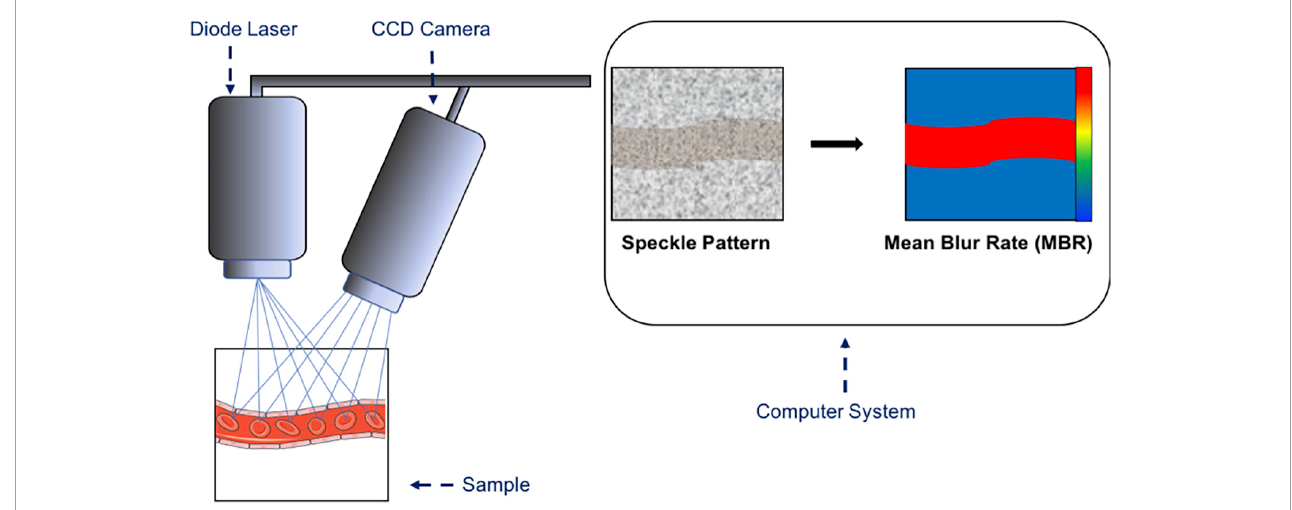
FIGURE4 Sketch of the principle of laser speckle flowgraphy. A microscope equipped with a diode laser is coupled to a charge-coupled device (CCD) camera. The laser light is reflected by the irregular surface of the fundus and is translated into a speckle pattern of the scattered light. The mean blur rate (MBR) is calculated from the speckle pattern and is a relative index of blood flow velocity in arbitrary units. The highest MBR is shown in red and the lowest MBR is shown in